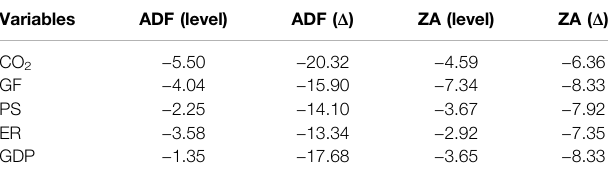
TABLE 3 | Results of unit root